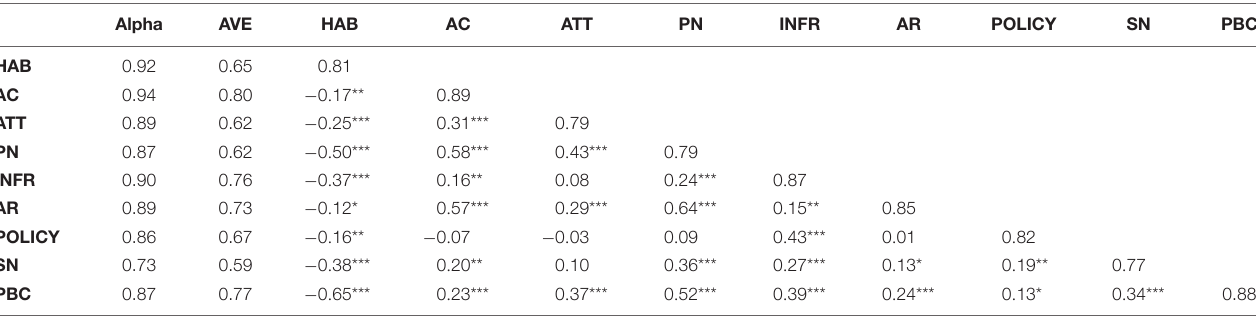
TABLE 2 | Validity measures and factor correlation